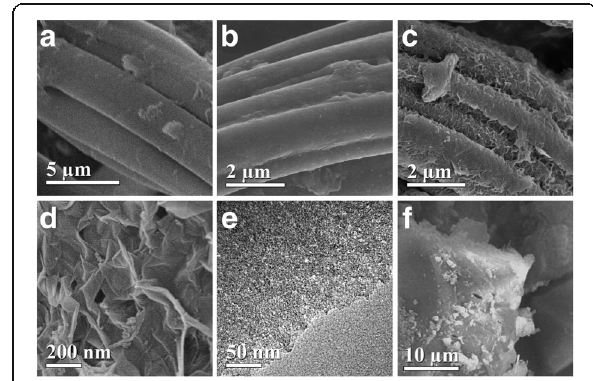
Fig. 3 SEM and TEM images. SEM images of a raw CG, b CGCF, c , d CGACF, and f commercial AC. e TEM image of CGACF